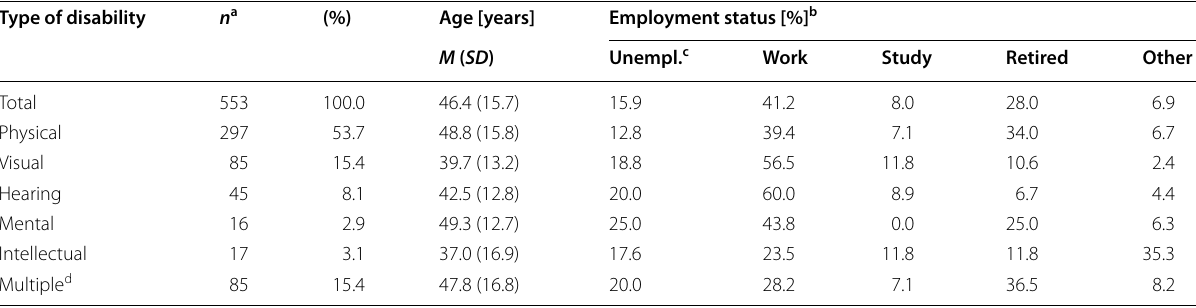
a n : Eight respondents did not fit in any of the subsamples. Therefore, the number of respondents in the subsamples does not add up to the total N b Due to rounding errors, employment status [%] does not add up to 100% in the subsamples ‘Visual’ and ‘Mental’, respectively c Unempl.: Unemployed d Multiple: More than one type of disability was